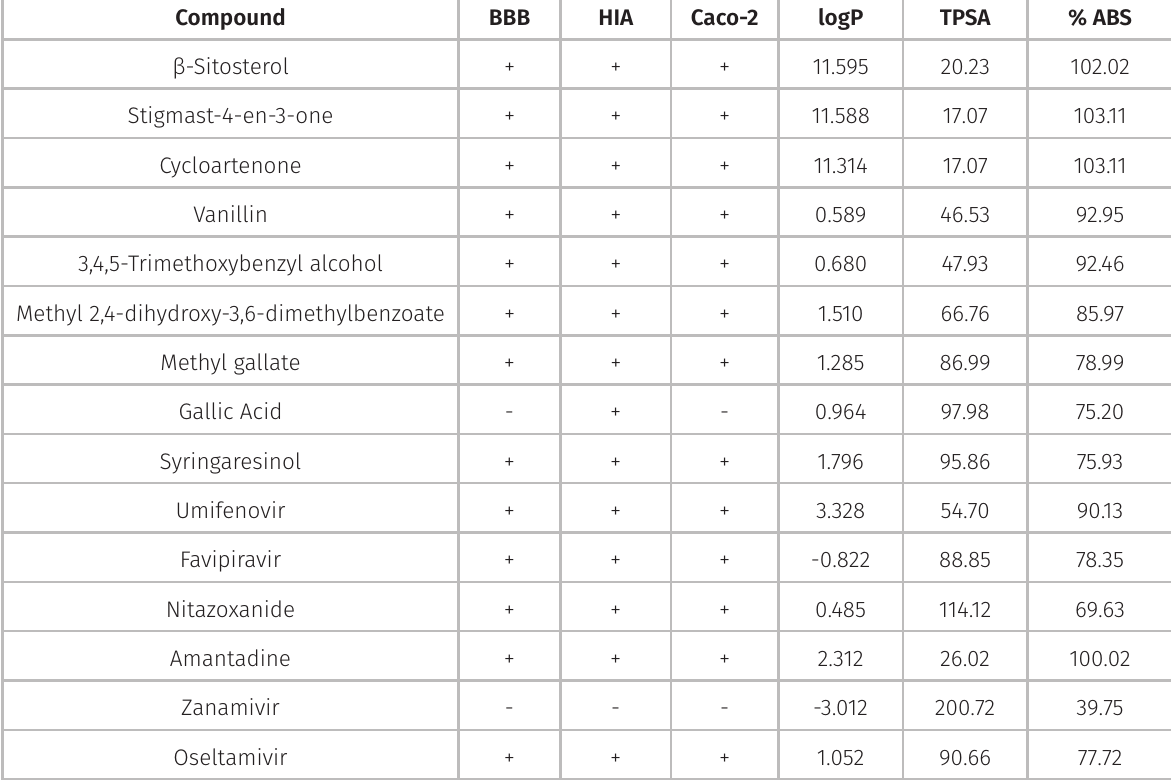
Table V. ADME properties and pharmacokinetic parameters of S. brasiliensis phytocompounds and positive controls. BBB: Blood-Brain Barrier; HIA: Human Intestinal Absorption; TPSA: Total Polar Surface Area; % ABS: Percentage of